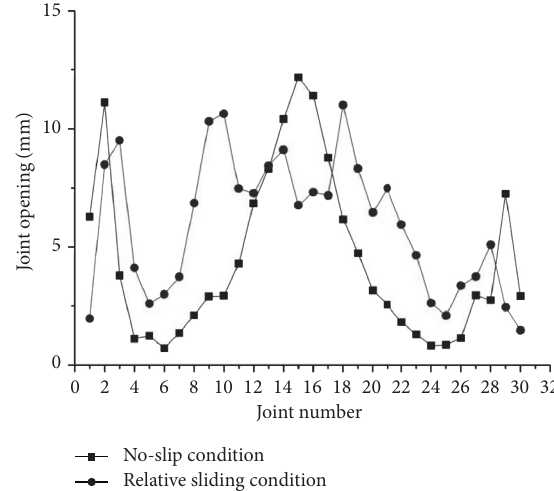
Figure 14: Joint opening at the upstream side of the dam crest under two